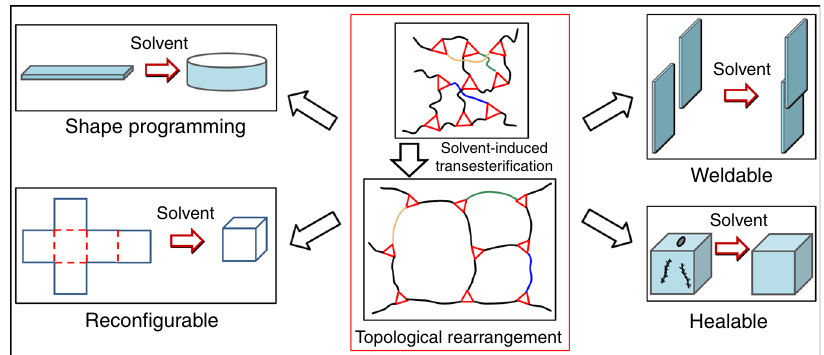
Fig. 1 Schematic of topological rearrangement induced by solvent-activated transesteri fi cation, which enables shape programming, recon fi guration, welding and healing of epoxy